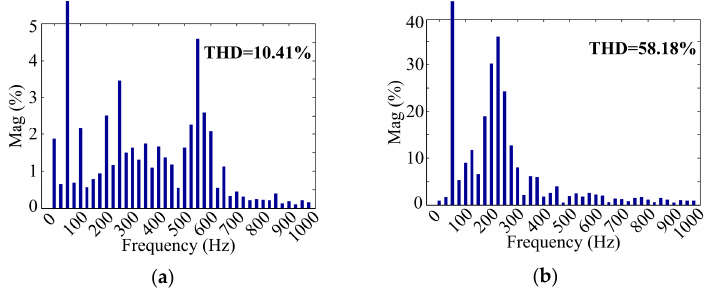
Figure 17. The FFT analysis of grid-connected converter starting in rectifier mode with SCVDFF. ( a ) SCR = 10; ( b ) SCR = 2.